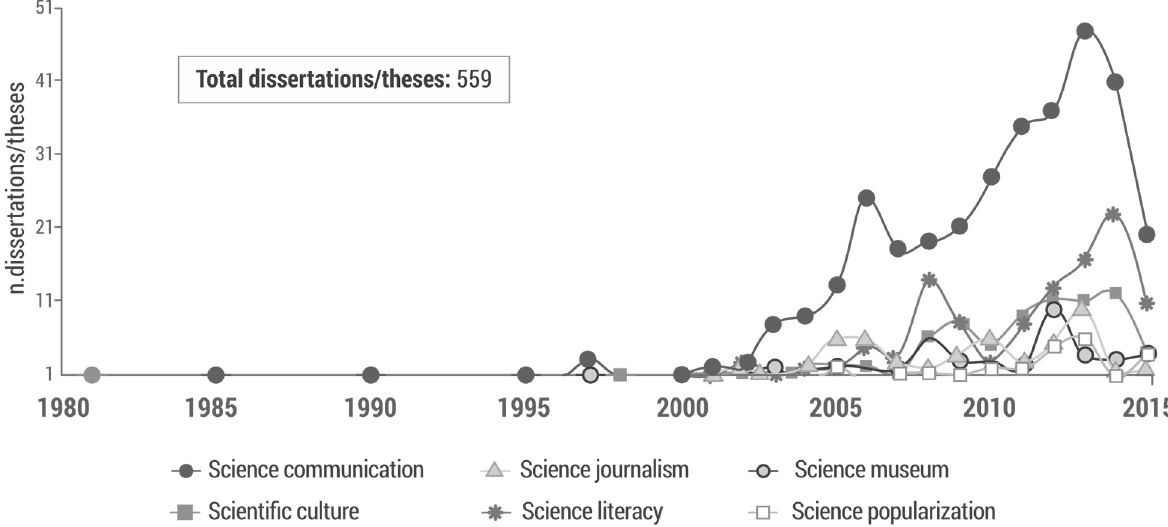
Figure 1 - Distribution of dissertations and theses published in Brazil (1980-2015). Based on data collected from IBICT